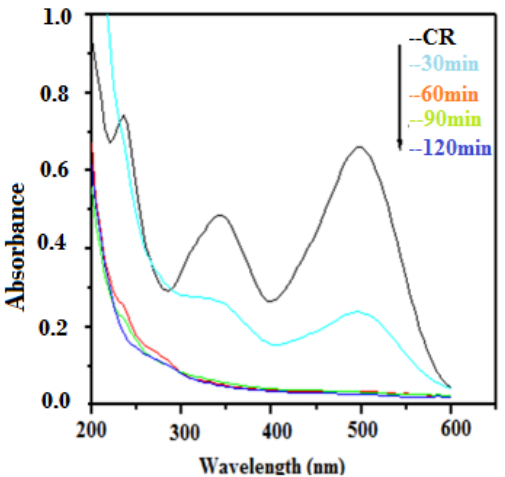
Fig. 7. Effect of irradiation time on Congo red